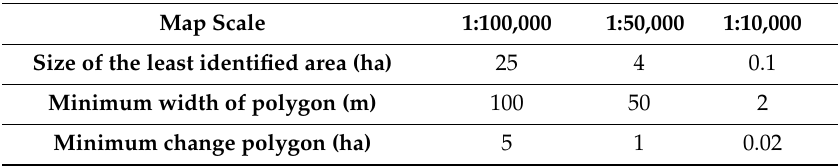
Table 2. Comparison of the size of the minimum mapped CLC areas on the 3rd, 4th, and 5th hierarchical levels.